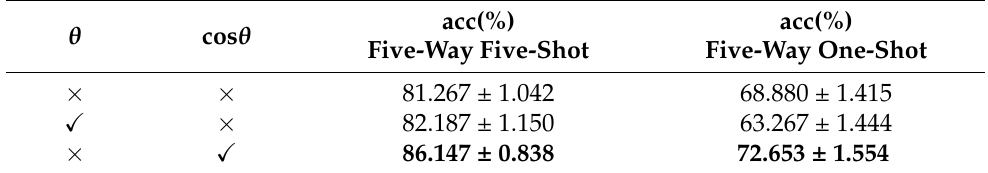
Table 7. Experiments on format of regression parameters. Note that θ denotes that θ is regressed before calculating cos θ and sin θ , and cos θ denotes that cos θ and sin θ is regressed simultaneously.